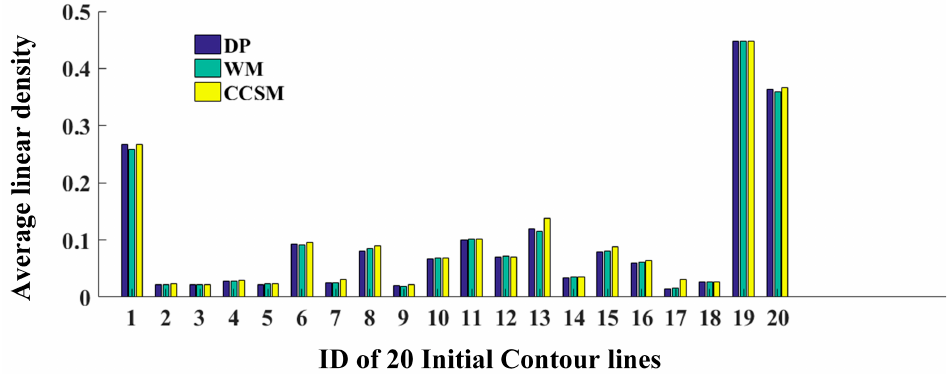
Figure 11. Average linear densities of the 20 selected contours generated by the three methods.